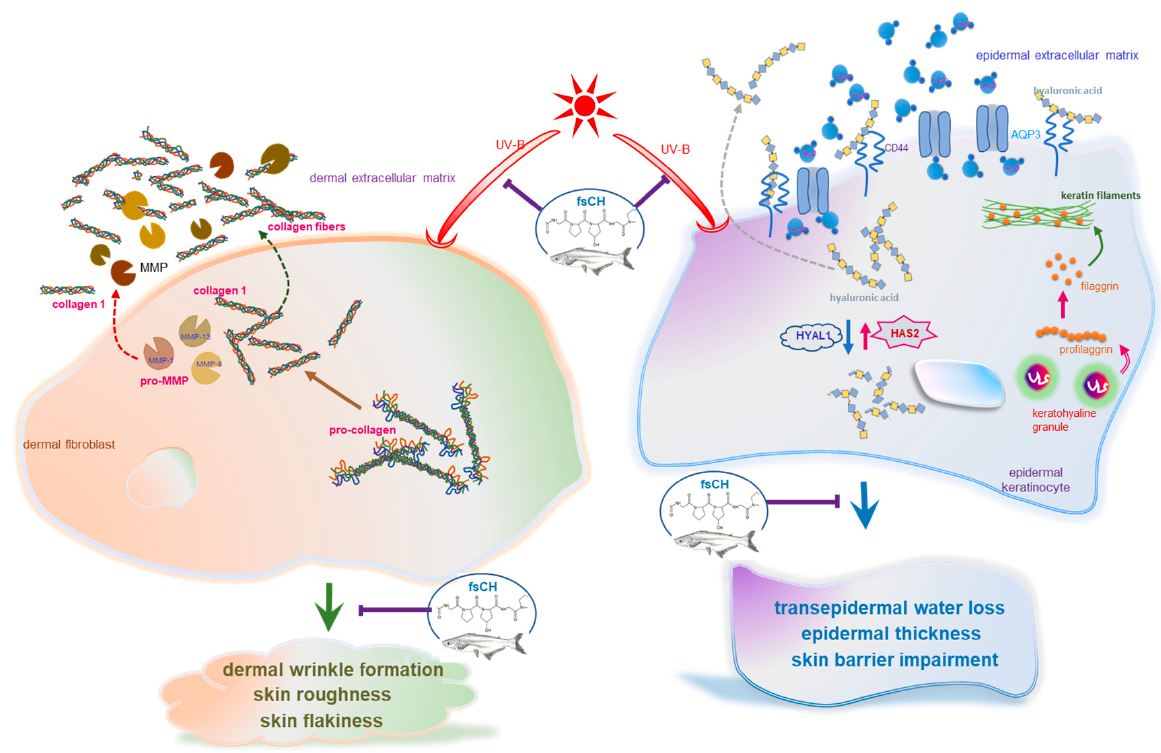
Figure 10. Schematic diagram showing the beneficial effects of Pangasius hypophthalmus fish skin hydrolysates (fsCH) on UV-B radiation-damaged skin of SKH-1 hairless mice. As depicted, fsCH attenuated dermal wrinkle formation in fibroblasts and epidermal water loss in keratinocytes. The symbol ⊥ indicates sites of inhibition manifested by fsCH and the symbol → indicates activation. UV-B, ultraviolet-B; MMP, matrix metalloproteinases; AQP3, aquaporin 3; HAS2, hyaluronic acid synthase 2; HYAL1, hyaluronidase 1.